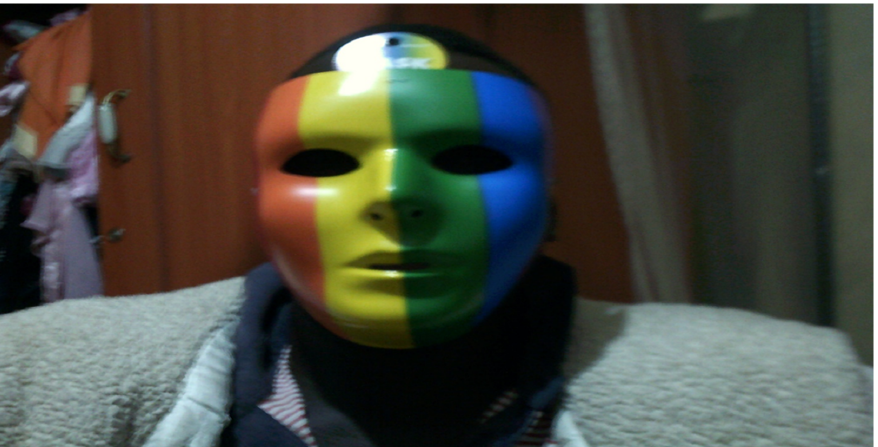
Figure 7. Participant’s partner at home after work, depressed and anxious because of workplace discrimination.